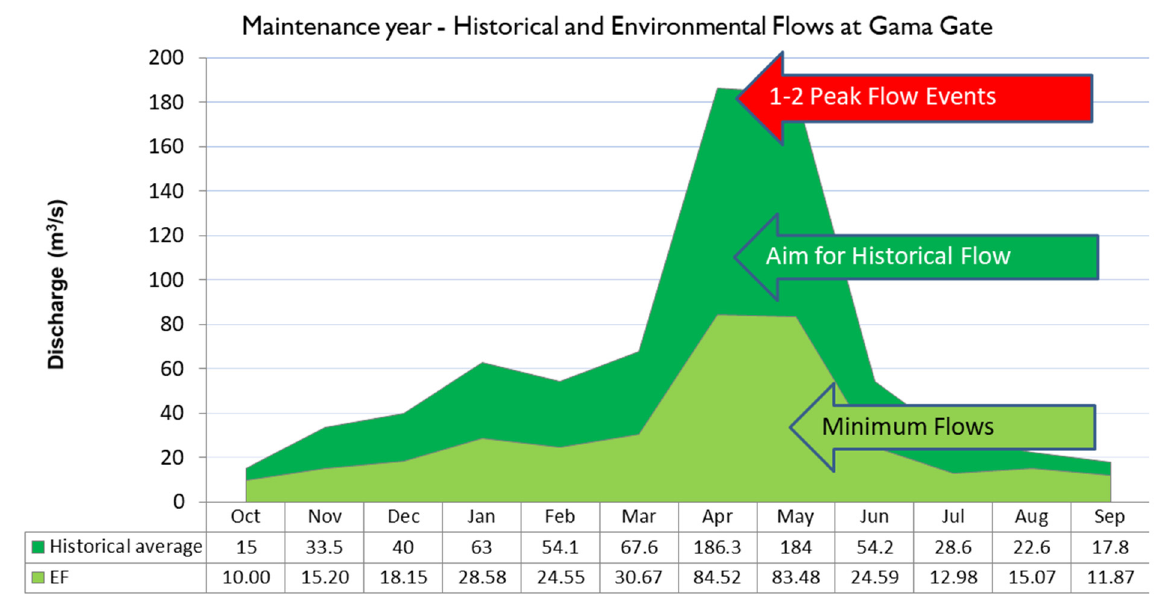
Figure 11. Recommended minimum freshwater flow (m 3 /s) guidelines at Gama Gate for a normal rainfall year.